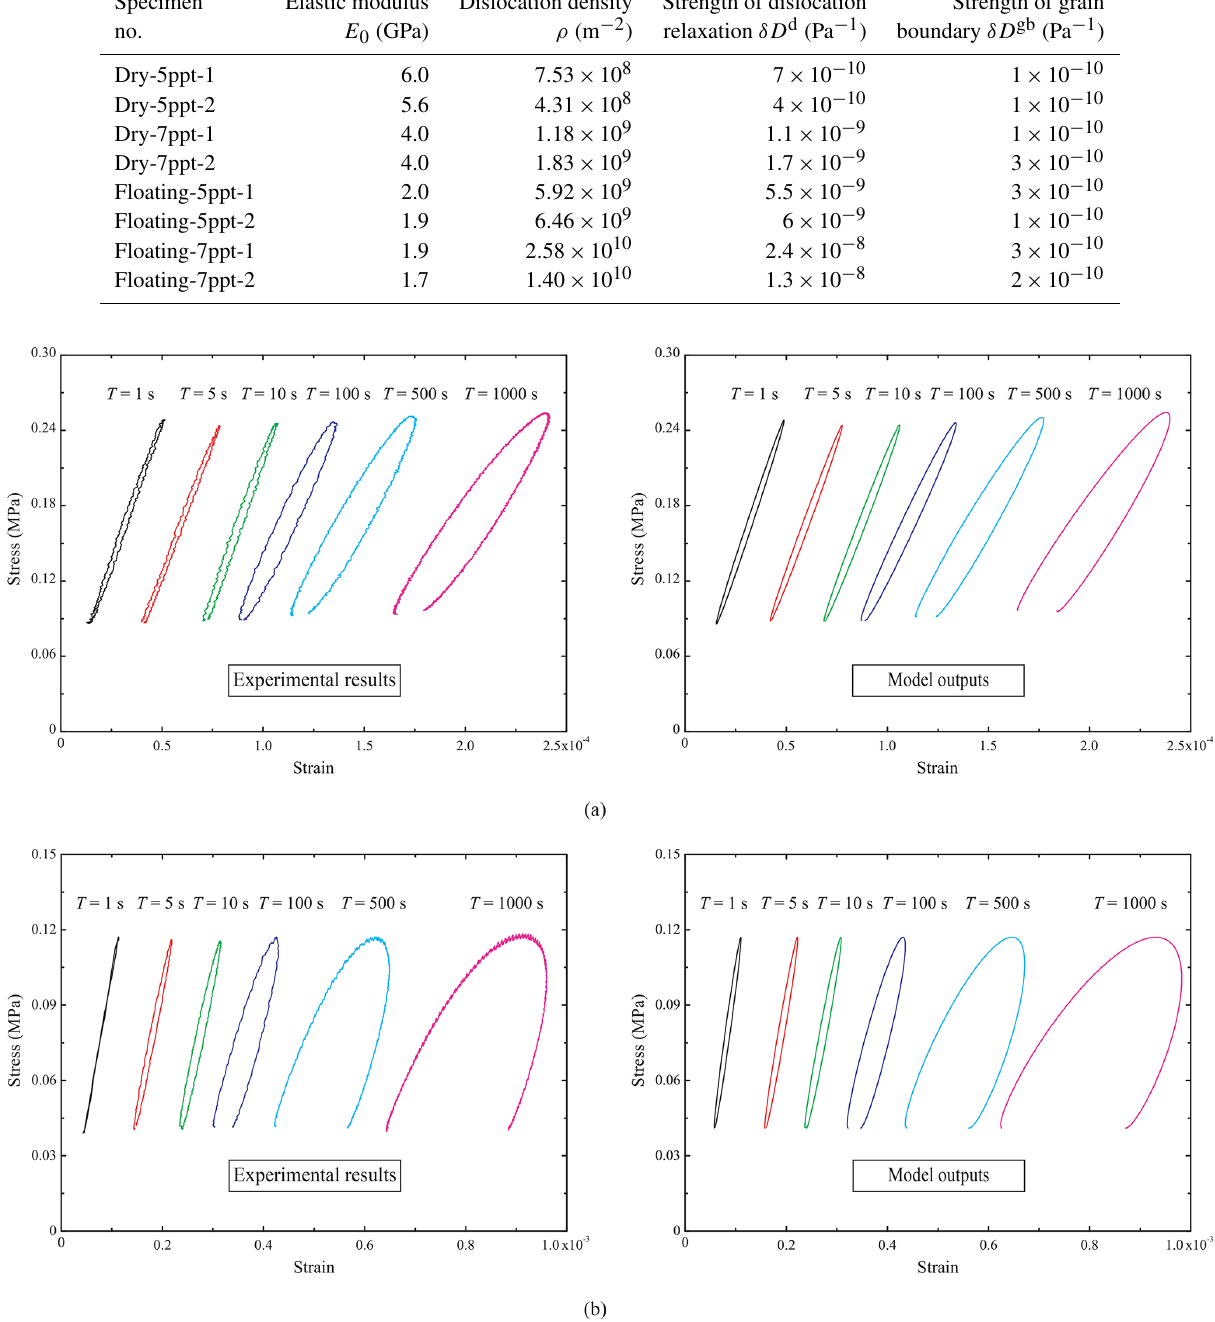
Figure 13. Comparison between the steady-state stress–strain hysteresis loop measured in the experiments and that outputted from the model for (a) specimen Dry-5ppt-1 with a temperature of − 10 ◦ C and (b) specimen Floating-5ppt-1 with an average temperature of − 2 . 5 ◦ C (note that, to compare the representative hysteresis loops in all the different-frequency experiments with those outputted by the model in a more concise and intuitive way, the prestrains before the hysteresis loops drawn here are not equal to the experimental